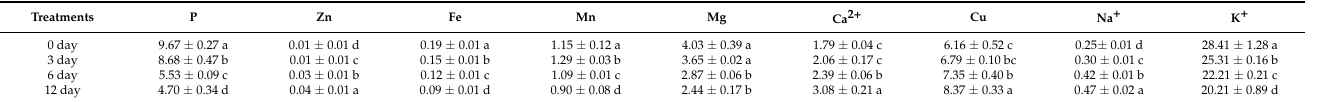
Table 2. Interactive effect of NaCl treatments on the macro and micro nutrients uptake in roots of tomato seedlings after 12 day under control and salanity stress.